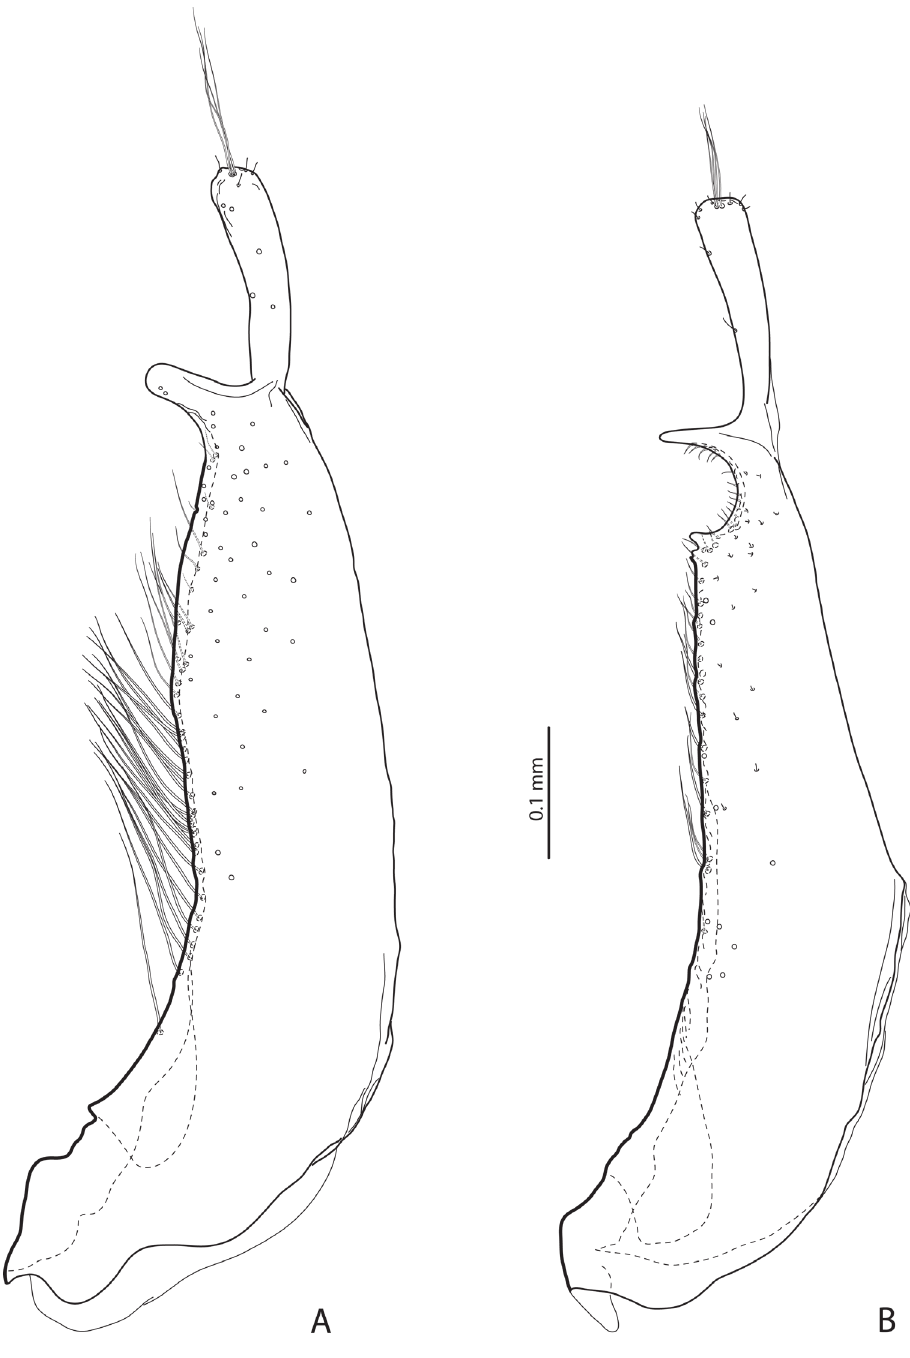
Figure 4. Paramere in external view A Exocelina baliem sp. n. B E. ferruginea (Sharp,